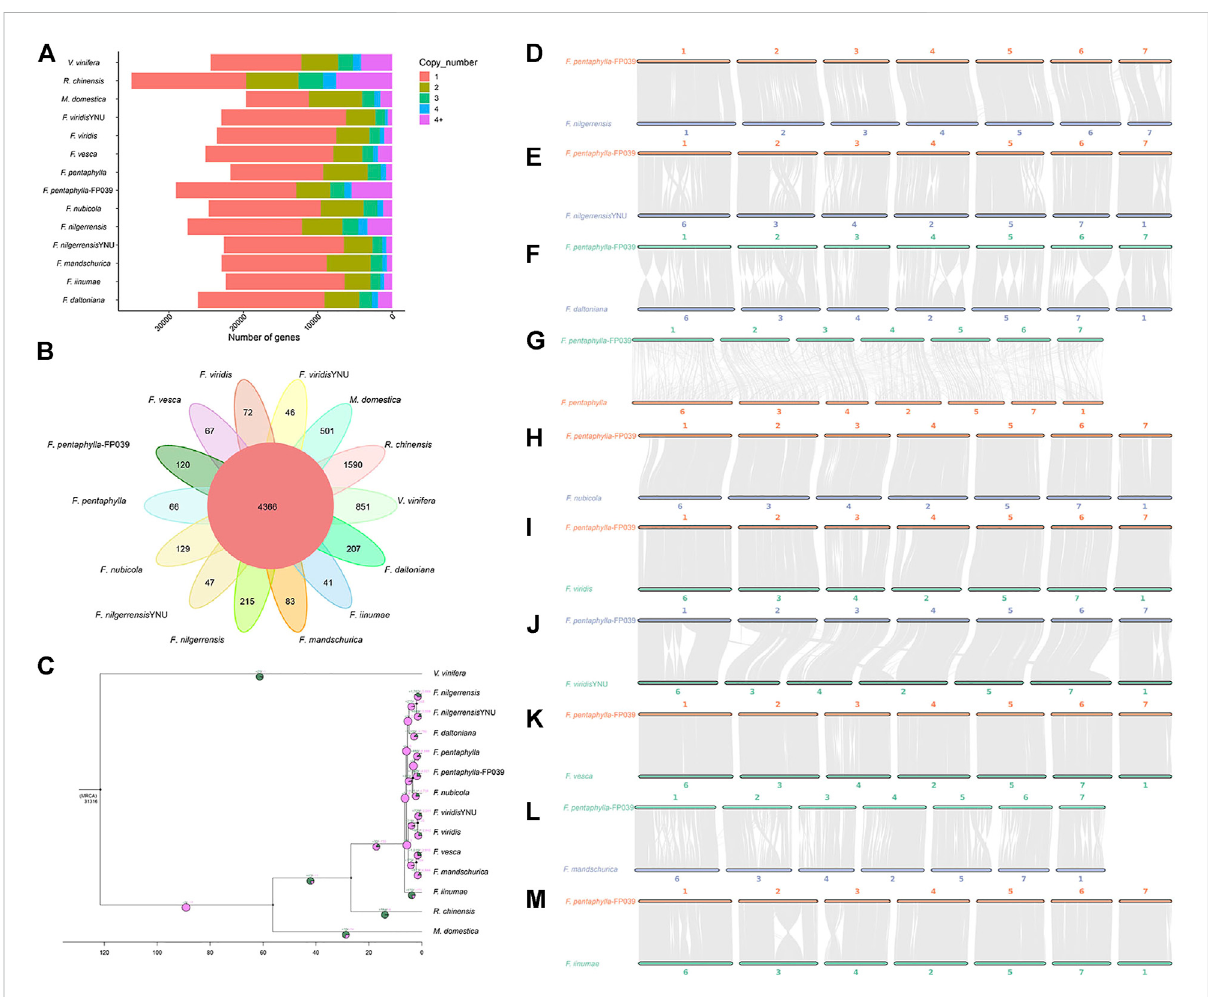
FIGURE 2 Comparativegenomicsanalysisof Fragariapentaphylla -FP039genomeandotherrepresentativeplantgenomes. (A) :Distributionofgeneswith differentcopynumberinanalyzedgenomes. (B) :Venndiagramofthesharedanduniqueorthogroupscalculatedamongthefourteengenomes.The numberofsharedorthogroupswasshowedinthecenter.Andnumbersofuniqueorthogroupsofcorrespondingspecieswereindicatedoutside. (C) : Phylogenetic tree of 14 plant genomes with numbers of expanded (+)/contracted ( − ) orthogroups at each branch. The ratio of expansion and contractionorthogroupsareindicatedinthepiediagramwithgreenandpurplecolor,respectively. (D – M) :Syntenyanalysis between F.pentaphylla - FP039 genome and the other ten genomes of diploid Fragaria